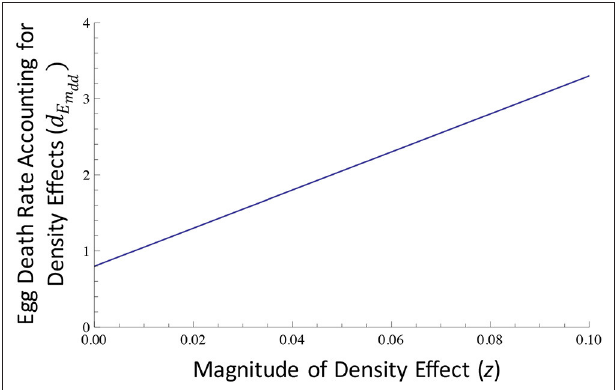
FIGURE 2 | The magnitude of density effects in relation to egg death rate. Egg death rate of mutant individuals increases as within-clutch density effects increase (see Equations 19–20 in the text for additional details). The term z is a measure of the magnitude of these density effects. As z increases, density effects increase, and egg mortality increases for a given within-clutch egg density, r m , with increasing z . Here, we assumed that: (i) within-clutch egg density, r m , was 25; (ii) baseline egg death rate ( d E ) was equal to 0.4; and m 0 (iii) the level of abandonment or filial cannibalism was equal to 0.4 (i.e., L = β = 0.4). In this case, we assume that both cannibalism and abandonment decrease egg survival, and as a result, the egg death rate after accounting for egg loss due to abandonment or cannibalism was equal to 0.8. If we assume that z = 0.01, which is the value of z assumed in most of our analyses below, density effects would cause egg mortality rate ( d E ) to increase to mdd approximately 1.05. If z were larger, density effects would cause egg mortality rate to be even